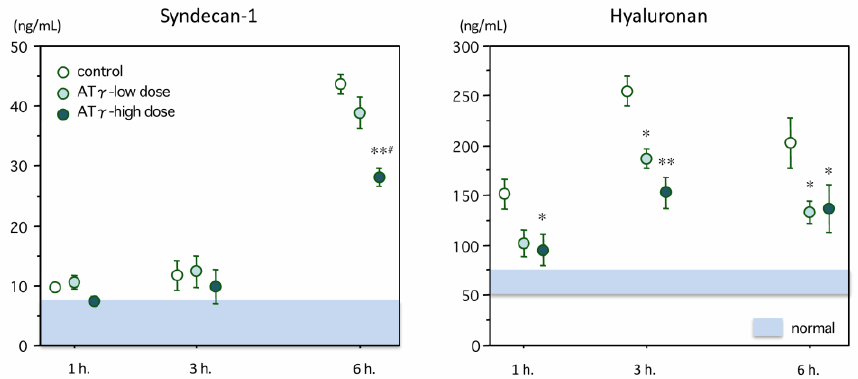
Figure 4. Changes in plasma levels of syndecan-1 and hyaluronan. Left: The syndecan-1 level was elevated at 6 h after lipopolysaccharide administration. The syndecan-1 level in the high-dose AT- γ group was significantly lower than that in the control group ( n = 7 in each group). Right: The plasma level of hyaluronan peaked at 3 h after lipopolysaccharide administration. The hyaluronan levels were significantly suppressed in the AT- γ groups. * p < 0.05 compared with the control group, ** p < 0.01 compared with the control group, # p < 0.05 compared with the low-dose group.